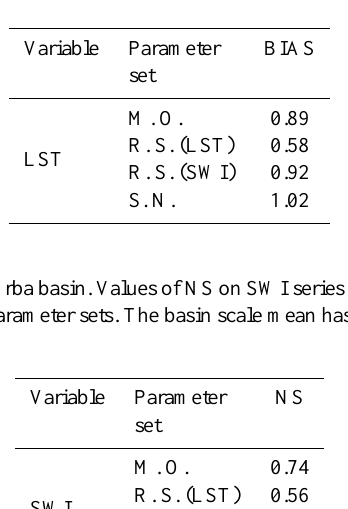
Figure 11. Nash–Sutcliffe coefficient of hydrographs ( x axis) ver- sus the multi-objective function (Fadj on y axis). The maximum of NS does not correspond with the minimum of the Fadj because this latter is influenced by the component that depends on LST ad SWI. Nevertheless, in correspondence of the minimum value of Fadj ( y axis) the NS value ( x axis) is around 0.9, which means good performance in terms of NS score.